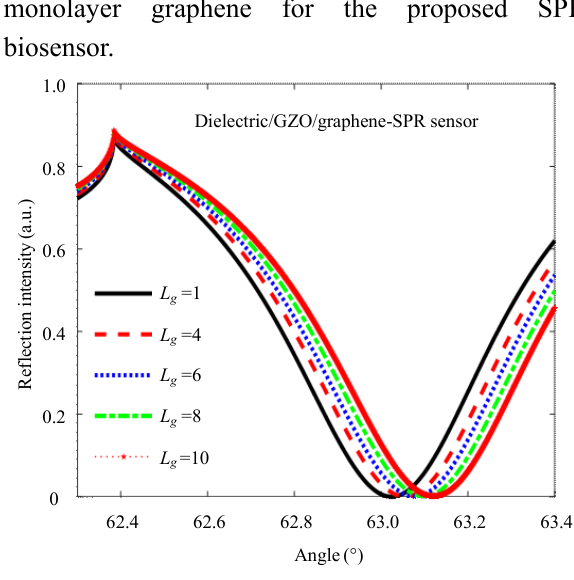
Fig. 6 Reflectance curves for proposed SPR sensor for 1 layer – 10 layers of graphene (thicknesses used for graphene, dielectric, and GZO are 0.34 nm, 2000 nm, and 20 nm, respectively; RIs for the dielectric medium and sensing medium are n d = 1.34 and n s = 1.33, respectively).